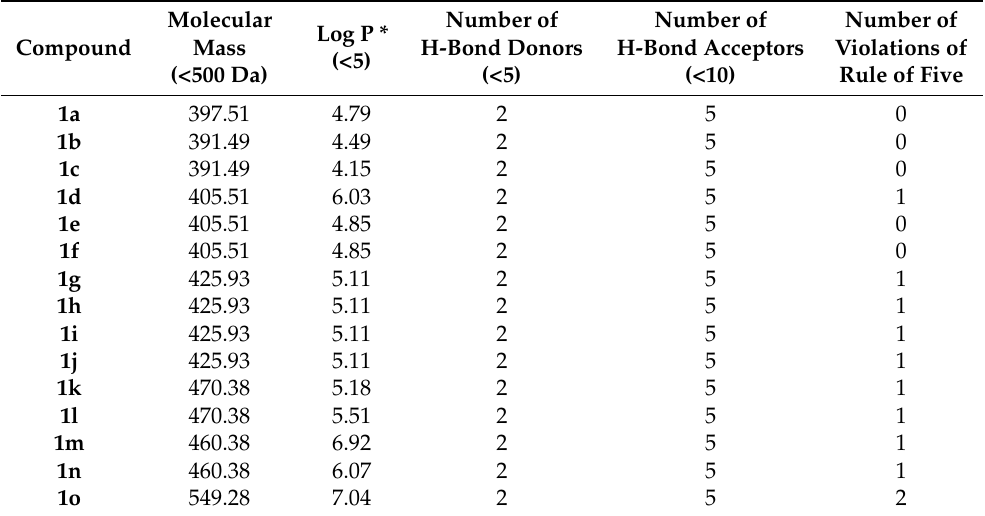
Table 4. Lipinski’s rule of five applied for the designed chemical compounds 1a – 1o .